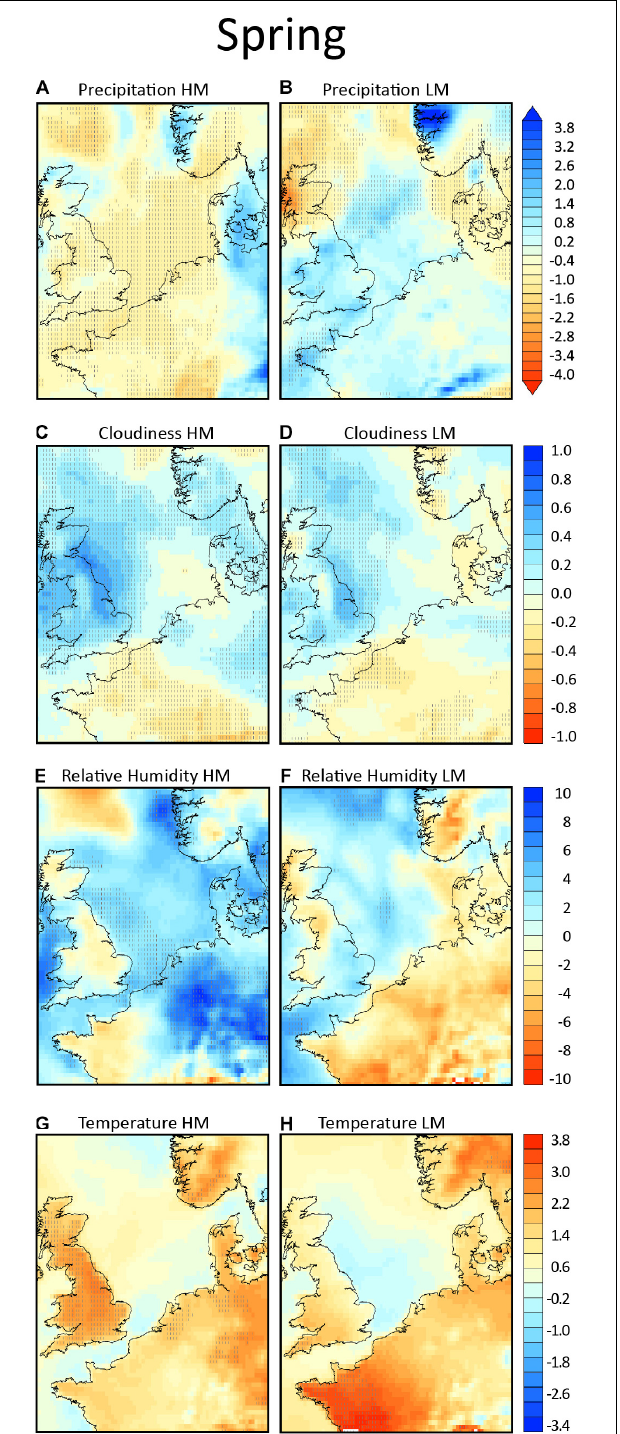
FIGURE 6 | Composites of anomalies from climatology in spring, in the left column for the high migration nights (HM) and in the right column for the low migration nights (LM). In panels (A,B) the total precipitation (in mm) is shown, in panels (C,D) the total cloud cover (units from –1 to +1), in panels (E,F) the relative humidity (in %) and in panels (G,H) the 2 m temperature field (in ◦ K). Areas exceeding the 95% confidence level are hatched.